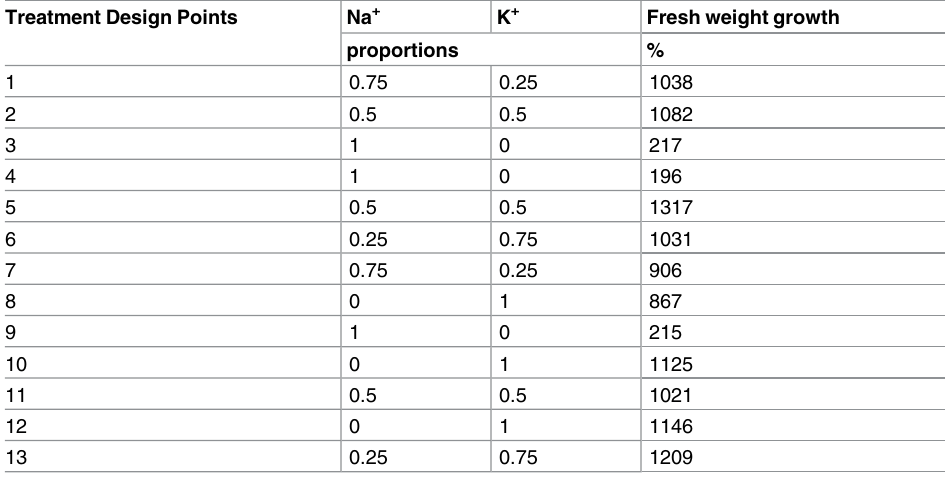
Table 5. Treatment design points and fresh weight growth data of a 2-component quadratic mixture design. The proportionsof K + and Na + were varied while the total amount was kept constant at 23.2 mM, the level in MS medium. For example, treatment point #1 would include17.4 mM Na + and 5.8 mM K + .